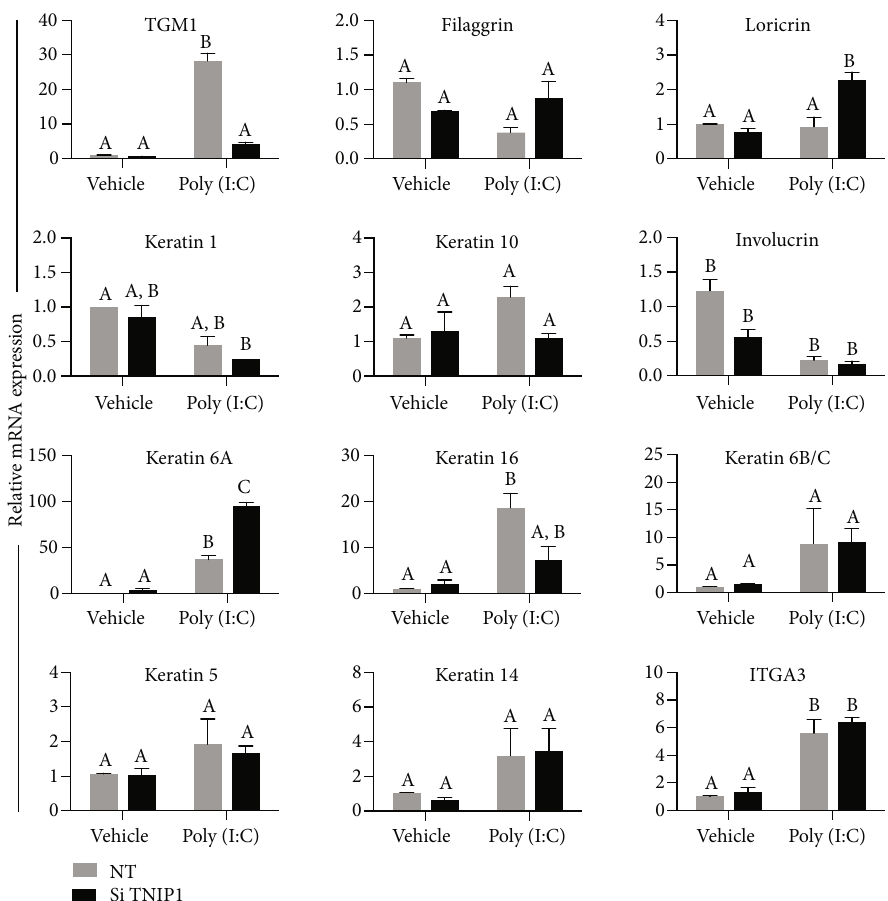
Figure 1: Keratinocyte di ff erentiation marker gene expression response to TNIP1 de fi ciency and poly (I:C). Gene expression was measured from HaCaT keratinocyte RNA collected 12hr post-poly (I:C) (1 μ g/mL) treatment (see Materials and Methods). mRNA levels were measured by qRT-PCR, normalized to RPL13a, and shown as fold change relative to nontargeting, vehicle. Data is presented as mean + SEM from two independent experiments. Means with a common letter are not signi fi cantly di ff erent by two-way ANOVA followed by Tukey ’ s post hoc test at a signi fi cance level of p ≤ 0 : 05 . TGM1: transglutaminase 1; ITGA3: integrin α 3. Transfections were done with nontargeting (NT) or TNIP1 small interfering RNA (Si